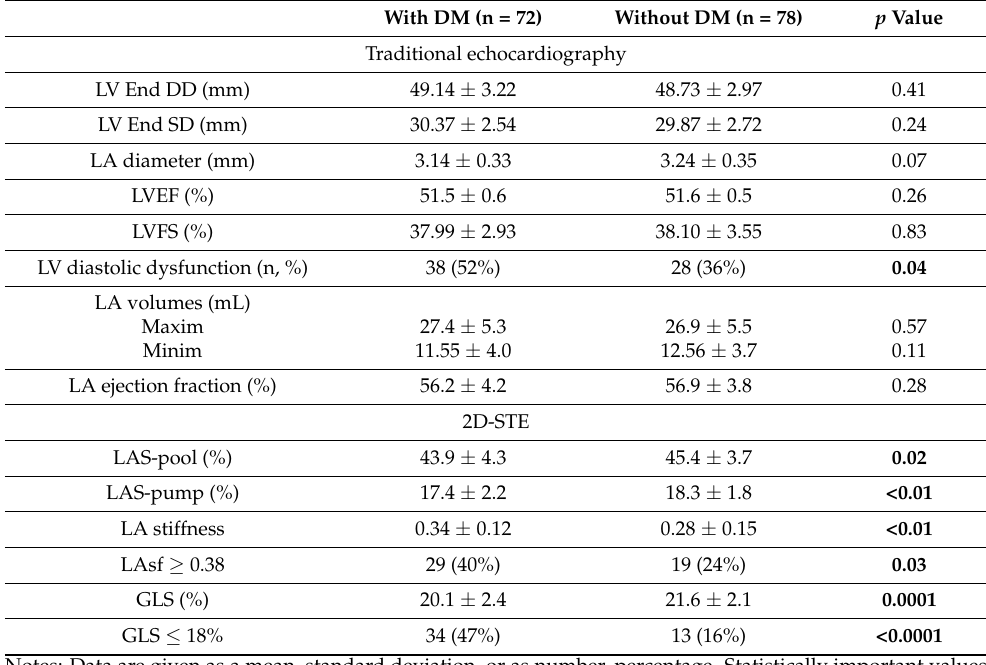
Table 3. LV echocardiography results in MetS patients.